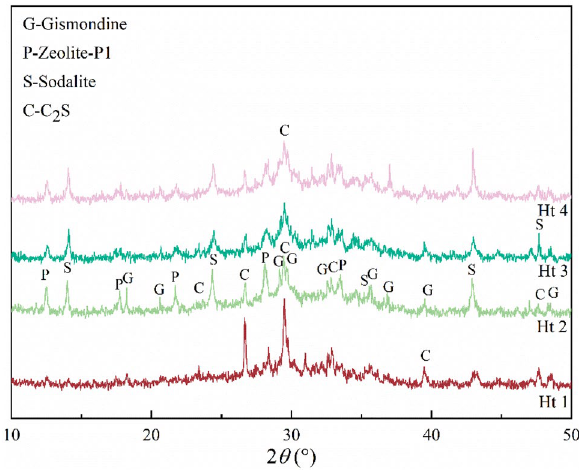
Figure 7. XRD patterns of hydrothermal products with different hydrothermal times; Ht 1: hydrothermal time at 6 h, Ht 2: hydrothermal time at 12 h, Ht 3: hydrothermal time at 18 h, Ht 4: hydrothermal time at 24 h.